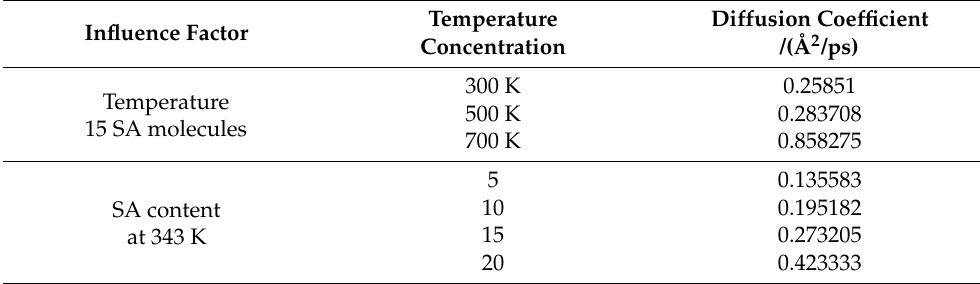
Figure 3. Mean square displacement (MSD) of water molecules in an oil-water-acid system with 20 SA molecules at 343 K. Table 2. Diffusion coefficient for oil-water-acid systems.